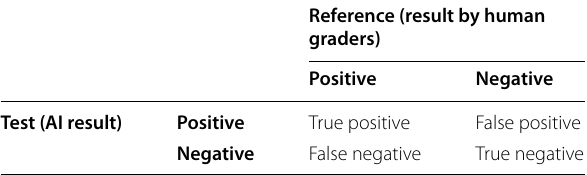
Table 2 Sample two‑by‑two contingency table used for analysis Reference (result by human